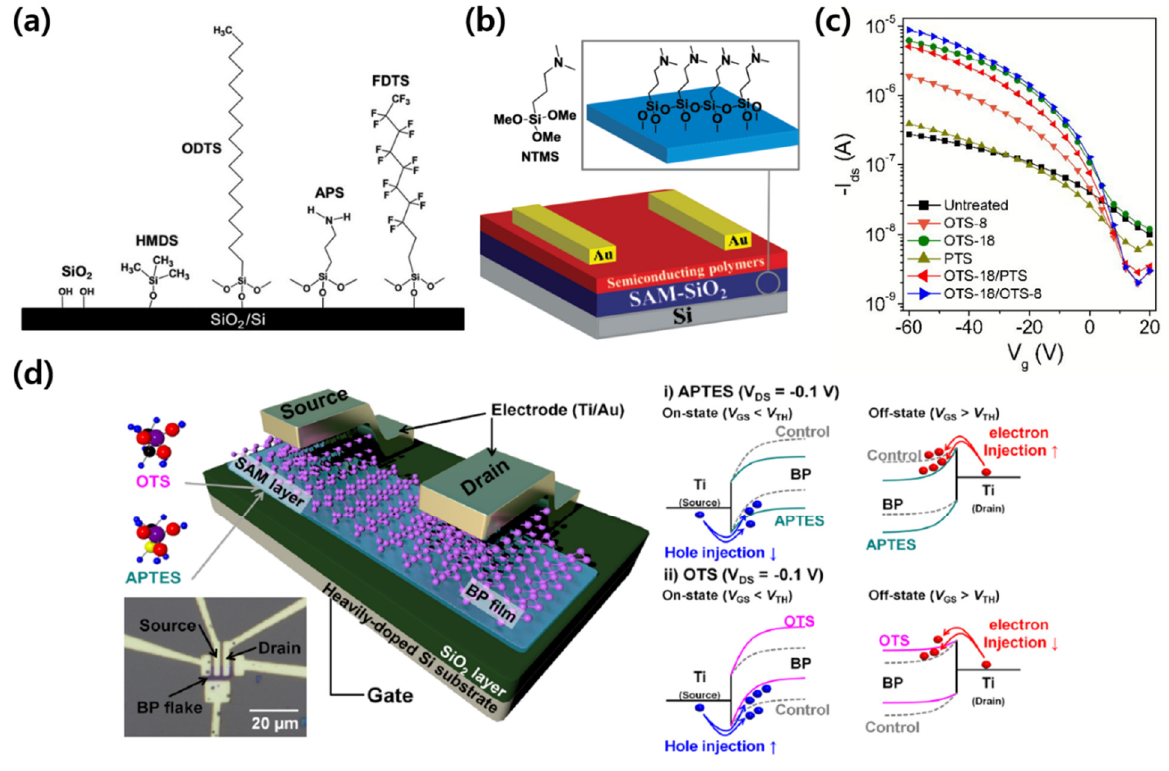
Figure 1. SAM treatment on SiO 2 gate dielectrics. ( a ) Various SAMs on the SiO 2 surface (adapted from [37] with permission from the Royal Society of Chemistry). ( b ) Structure of a pSNT transistor with NTMS-treated SiO 2 and the chemical structure of NTMS (adapted from [38] with permission from John Wiley and Sons). ( c ) Transfer characteristics of a poly(3- hexylthiophene) (P3HT) transistor before/after various silane-based SAM treatments on SiO 2 (adapted from [39] with permission from the Royal Society of Chemistry). ( d ) BP transistor with ODTS- and APTES-treated SiO 2 gate dielectric and the energy band diagram before/after each SAM treatment (adapted from [40] with permission from the American Chemical Society).